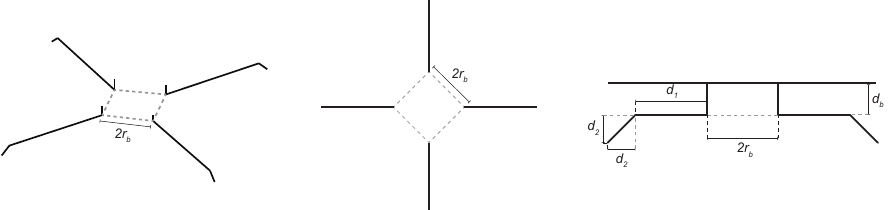
Figure 18. Structure of grounding system MT2 and MT4, commonly adopted along Italian transmis- sion lines (not in scale).